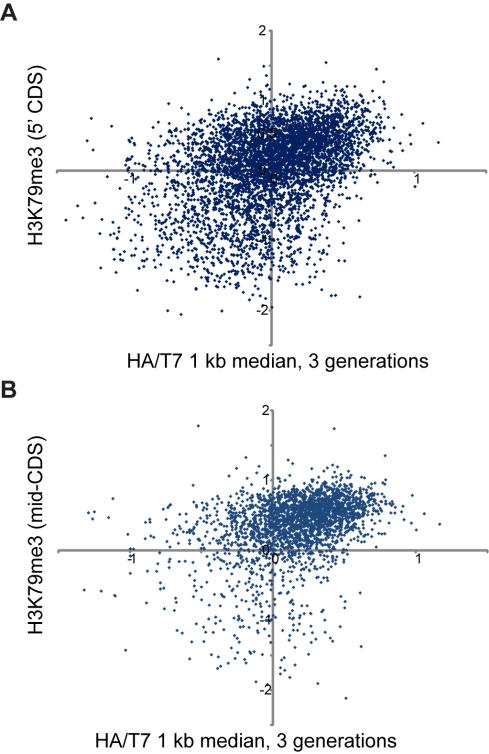
Ancestral H3 retention and histone modification patterns.(A) Scatterplot of previously measured H3K79me3 [52] levels averaged
over the 5′ CDS of genes versus the median HA/T7 for the 5′
1 kb of each gene. (B) As in (A), for K79me3 averaged over mid-CDS of
each gene.